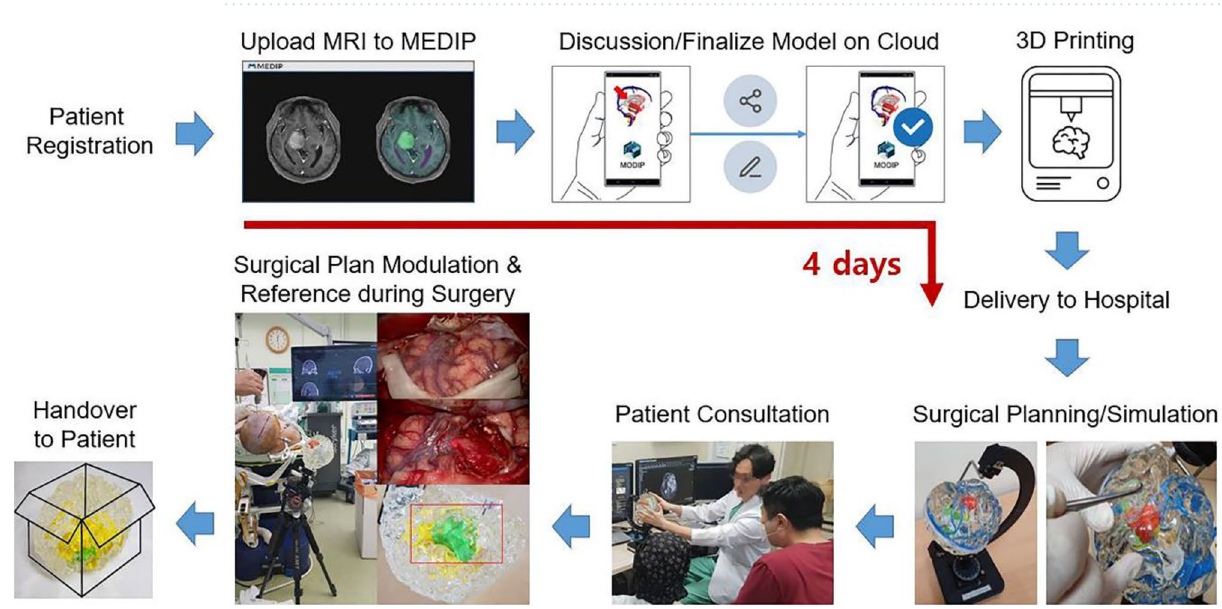
Figure 5. Clinical application flow of the 3D-printed brain tumor